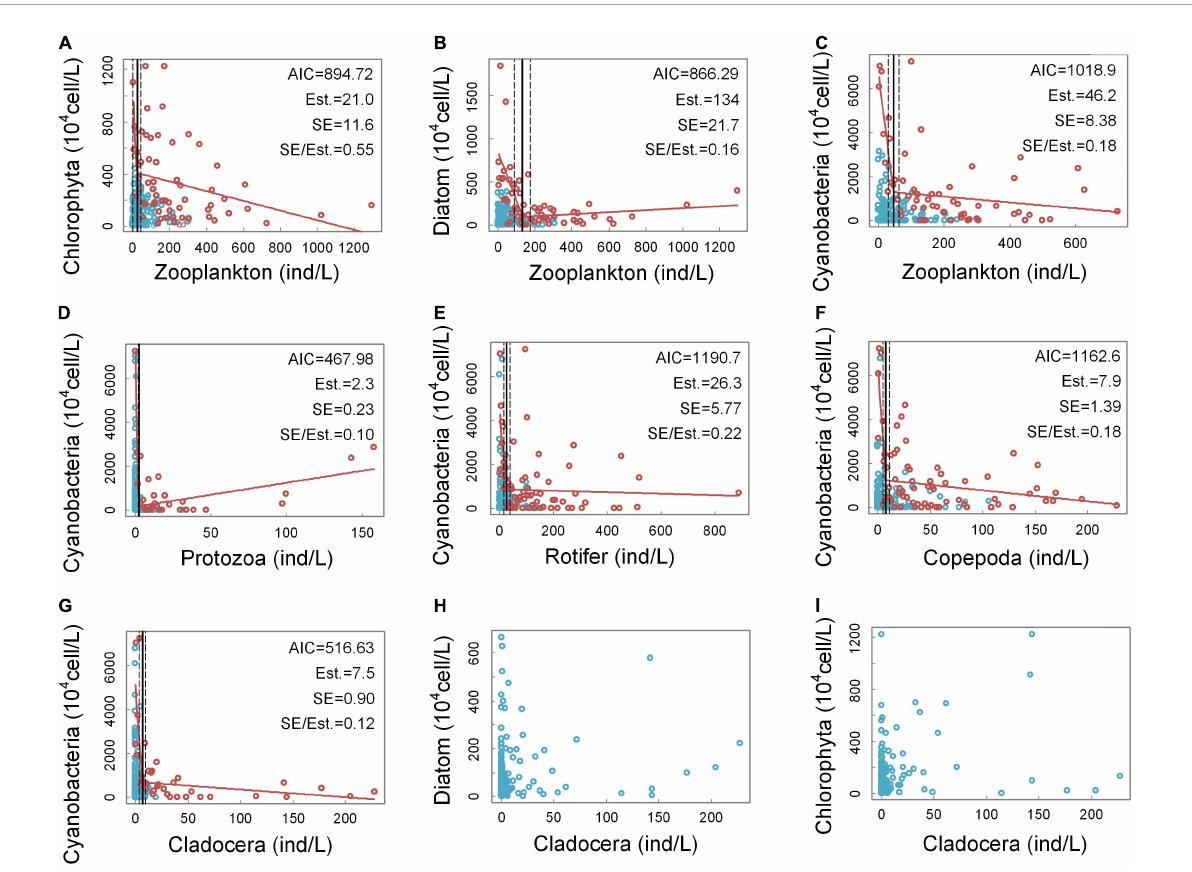
FIGURE3 Quantitative relationships between the densities of the groups of zooplankton and phytoplankton. In panels (A–G) , the horizontal axis intervals used in the selection of the edge scatter points are 5 ind/L, 5 ind/L, 5 ind/L, 1 ind/L, 2 ind/L, 2 ind/L, and 1 ind/L, respectively. In panel (D) , a singular point with extremely high protozoan density is excluded. This sample point is located in Xinglin Reservoir, Jinan. At this site, the density of protozoa reached 888 ind/L, and the density of cyanobacteria was 723.8 · 10 4 cell/L. Panels (H–I) cannot select edge scatter